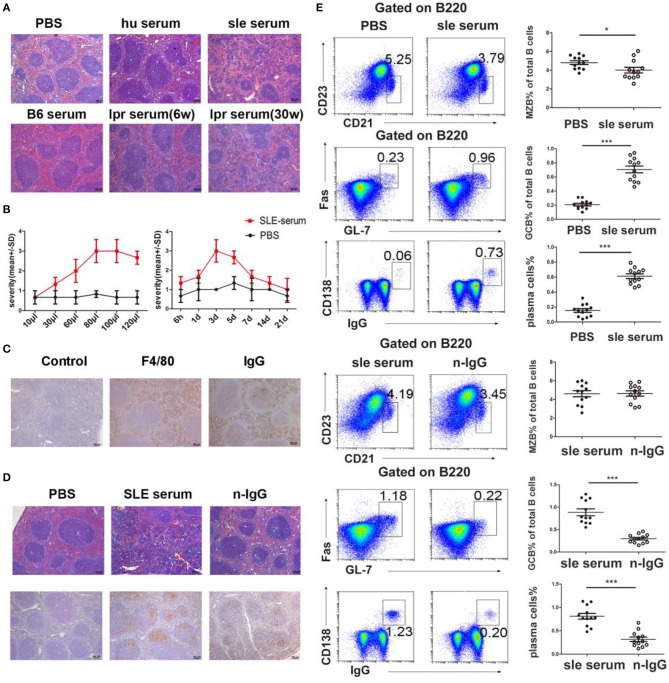
Lupus IgG-induced splenic red pulp inflammation and GC responses. (A) Histopathological image of the spleen of C57BL/6 mice at 3 days after intrasplenic injection of serum (80 μl) from healthy individuals, SLE patients, B6.MRL/lpr mice (30 and 6 weeks), and serum from C57BL/6 mice; PBS injection was used as a control. (B) Severity of red pulp inflammation induced by intrasplenic injection with different volumes of serum from a lupus patient (left panel), and the kinetics of inflammation on different days after intrasplenic injection of lupus serum (80 μl) (right panel). (C) IHC results of F4/80 and IgG staining in the spleen of C57BL/6 mice 3 days after the injection of SLE patient serum. (D) Histopathological image of red pulp inflammation 3 days after injection of PBS, SLE patient serum, and IgG-depleted SLE patient serum. IHC results of peanut agglutinin (PNA) 8 days after injection of PBS, SLE patient serum, and IgG-depleted SLE patient serum. PNA staining was used for GC identification. (E) FACS analysis of the frequency of MZB cells (B220+CD21/35hiCD23lo), germinal center B (GCB) cells (B220+Fas+GL7+), and IgG-secreting plasma cells (IgG+CD138+) 8 days after intrasplenic injection of PBS, SLE patient serum, and IgG-depleted SLE patient serum in the spleens of C57BL/6 mice. All results are representative of three independent experiments; n = 4–5 mice per group. *P < 0.05, ***P < 0.001.